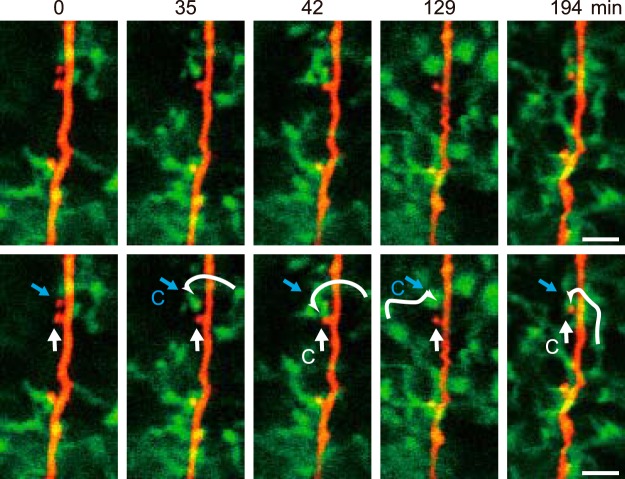
Specific physiologic microglial processes contact different spines while a single spine may be contacted by different microglia. Representative long-term simultaneous images of microglia (green) and of dendrites and spines (red), showing examples of microglial-synapse contacts during over three consecutive hours. The upper and lower panels show the same images with the lower panels annotated by white and blue straight arrows to indicate two different spines, and with a curved white arrow to indicate the trajectory of for a single microglial process as it contacts a spine (contact indicated by C). The upper spine (blue arrow) is contacted by one microglia at 35–42 min, and by a seemingly different microglia at 129 min. At 42 and 194 min, the original microglia contacts the lower (white arrow) spine.